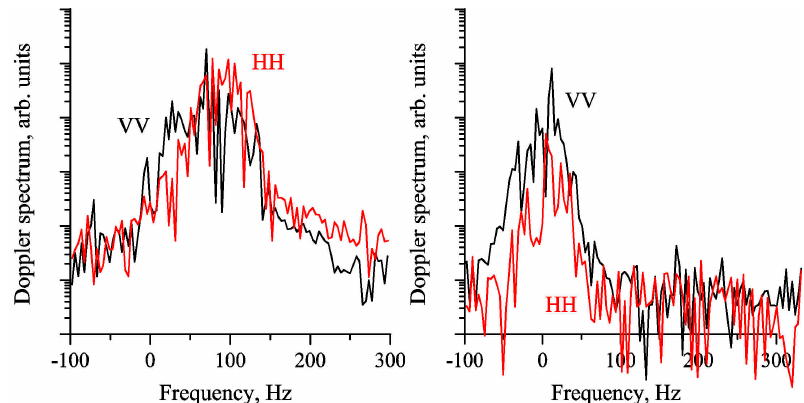
Figure 4. Examples of radar Doppler spectrum near a DWW crest ( left ) and near a DWW through ( right ). Black curves – VV-polarization, red curves – HH-polarization. Upwind observations, wind velocity is 10 m/s.